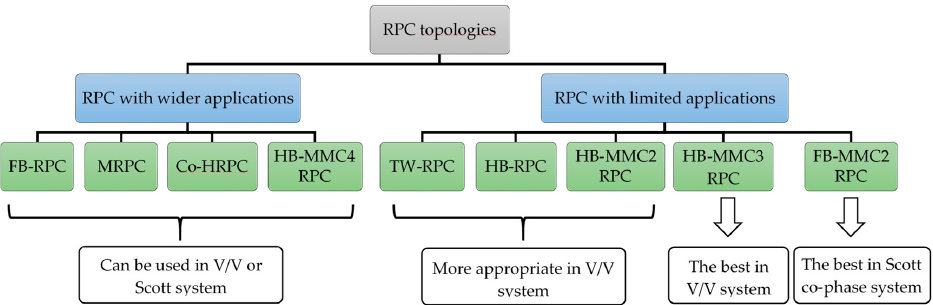
Figure 24. Final classification of the RPC topologies (based on [6–8,10,33]).